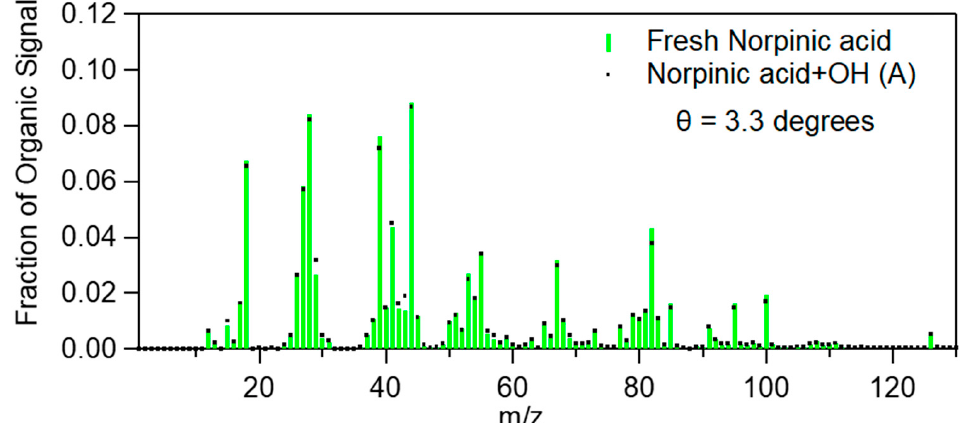
Figure 4. Comparison of the mass spectra of fresh norpinic acid aerosol (taken while the UV lights were off) and the mass spectrum from the period (A) as indicated in Figure 3.